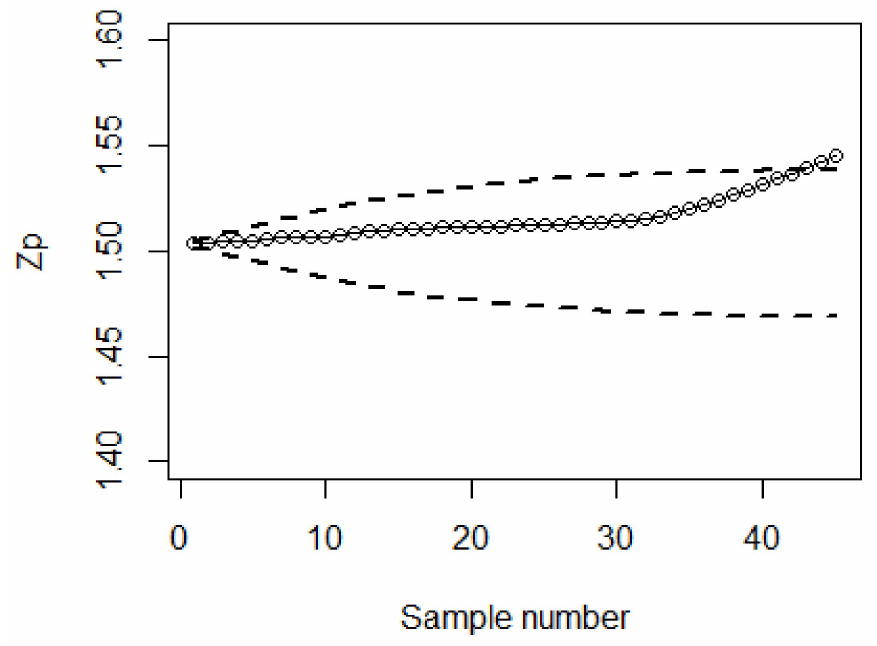
Figure 1. Bayesian HEWMA control chart using posterior and posterior predictive distribution under SELF for SRS.